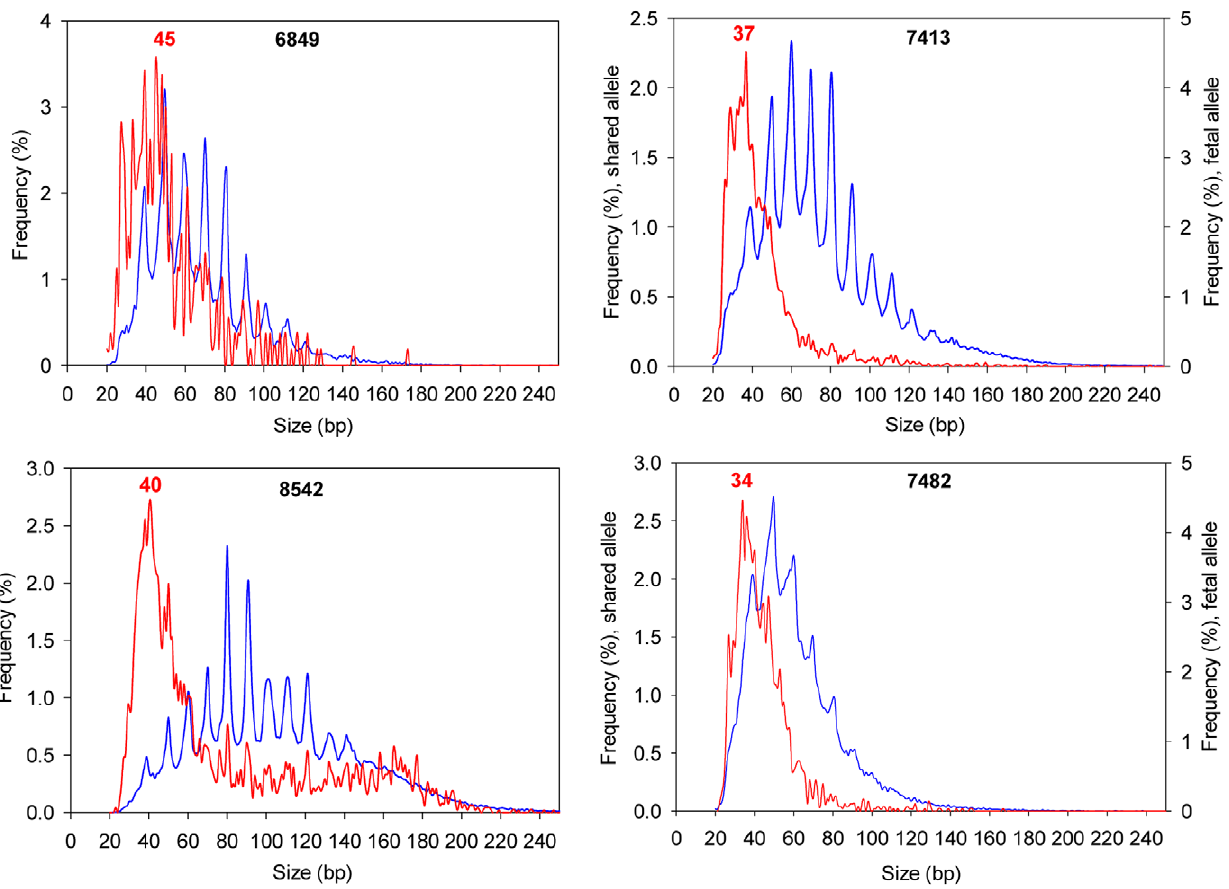
Figure 4. Size distribution of DNA fragments in maternal urine. Size distributions of fetal DNA (red curves) and maternal DNA (blue curves) in the maternal urine in cases 6849, 7413, 7482 and 8542. The numbers denote the DNA sizes of the predominant urinary fetal DNA peak in each sample.